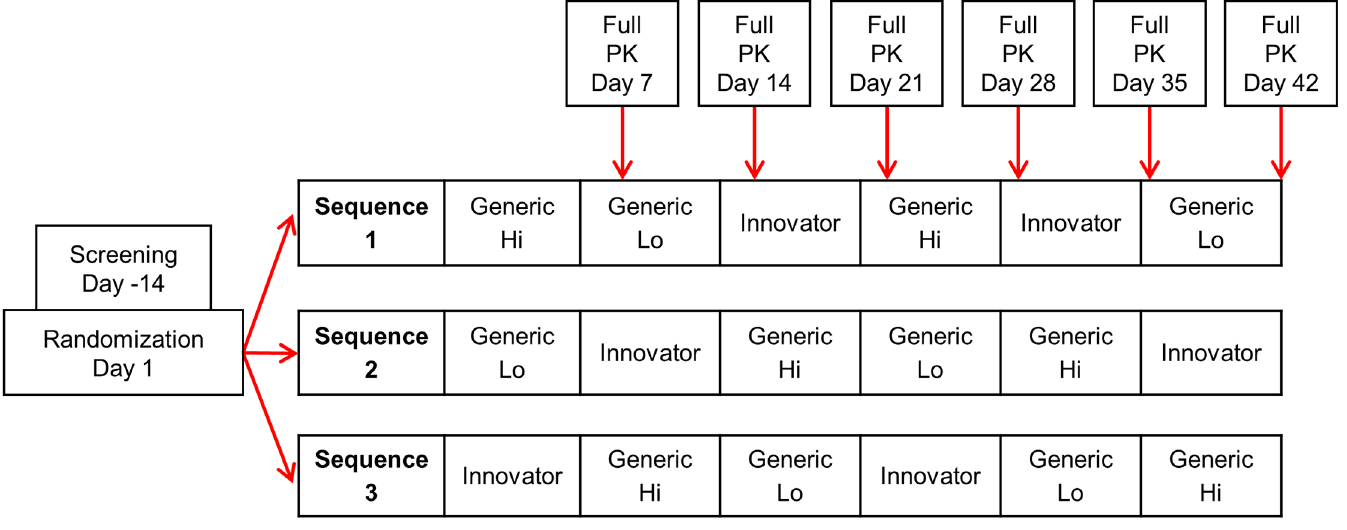
PLOS Medicine| https://doi.org/10.1371/journal.pmed.1002428 November14,